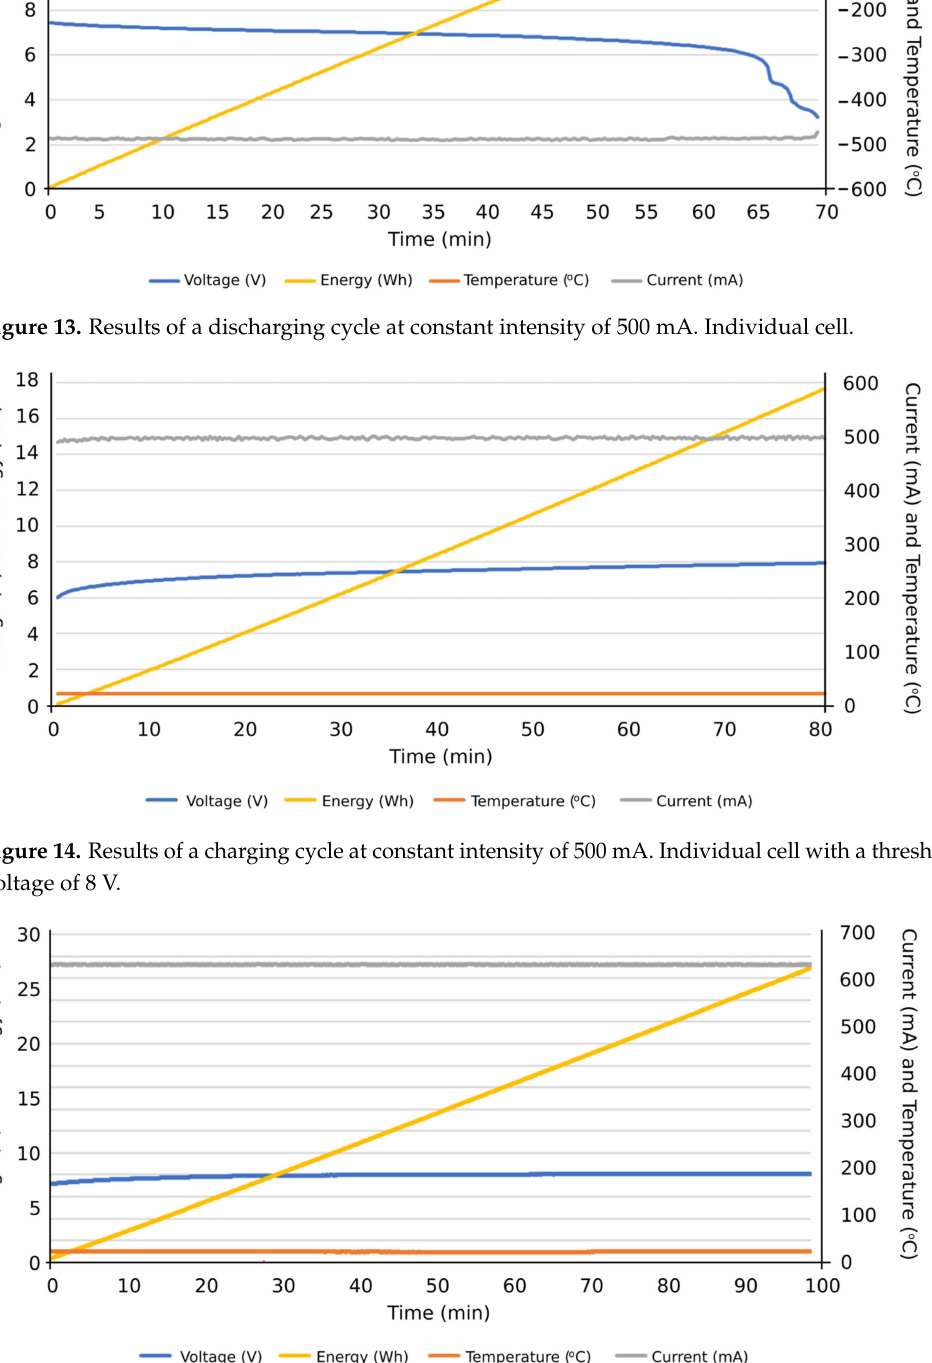
Figure 15. Results of a charging cycle at a constant intensity of 600 mA. Individual cell with a threshold voltage of 8.1